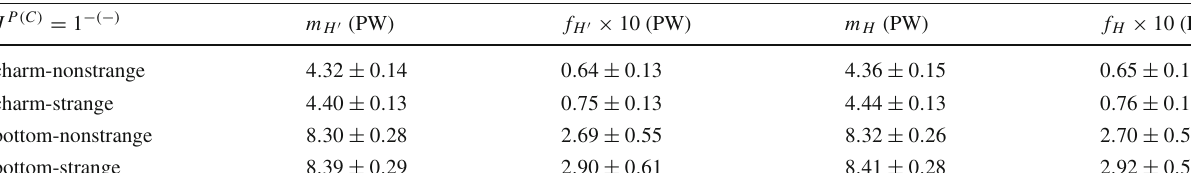
belong to the results up to dimension six and those without prime show the results up to ten mass dimensions. The masses are in GeV and the current couplings are in GeV 3